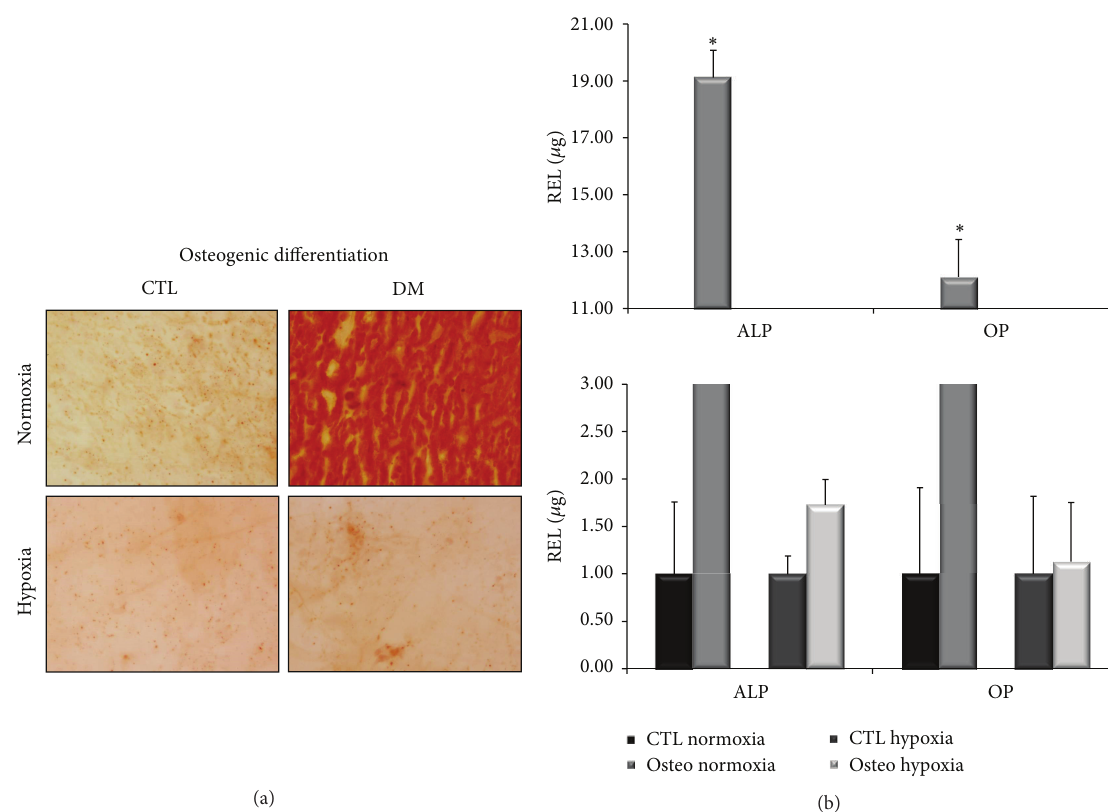
Figure 3: Staining techniques of osteogenic differentiated cells and osteogenic-specific gene expression levels in normoxic and hypoxic conditions. (a) Alizarin red staining of the cells differentiated (DM) compared to their control point (CTL). The photos are relative to day 21 of cultures in normoxic and hypoxic conditions. (b) We compared controls points (CTL) and treated cells (Osteo.). Expression levels of ALP and OP at day 21 of cultures in normoxic ( ∗ 𝑃 < 0.05 ) and hypoxic conditions.